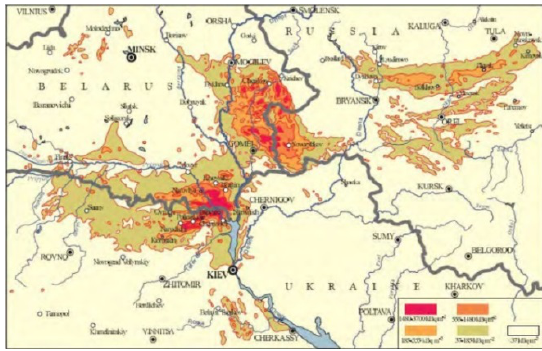
Figure 15. Radioisotope pollution patterns in